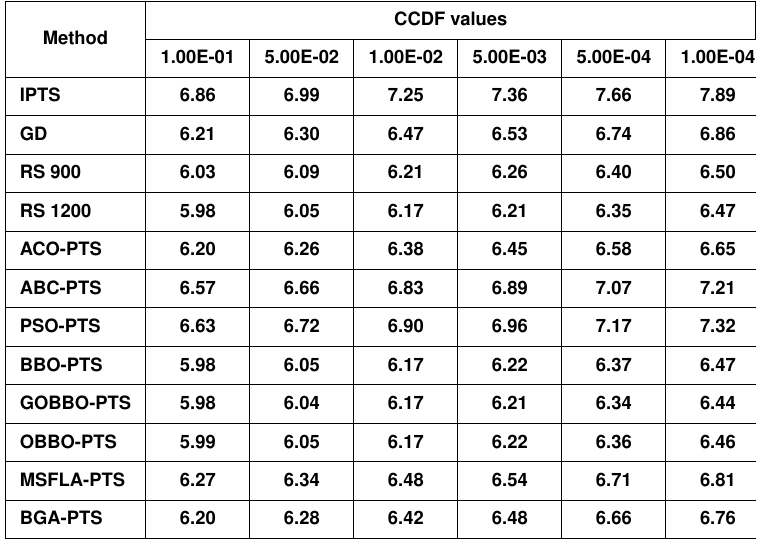
Table 5. Comparison of PAPR values (dB) for different CCDF values among different PTS schemes